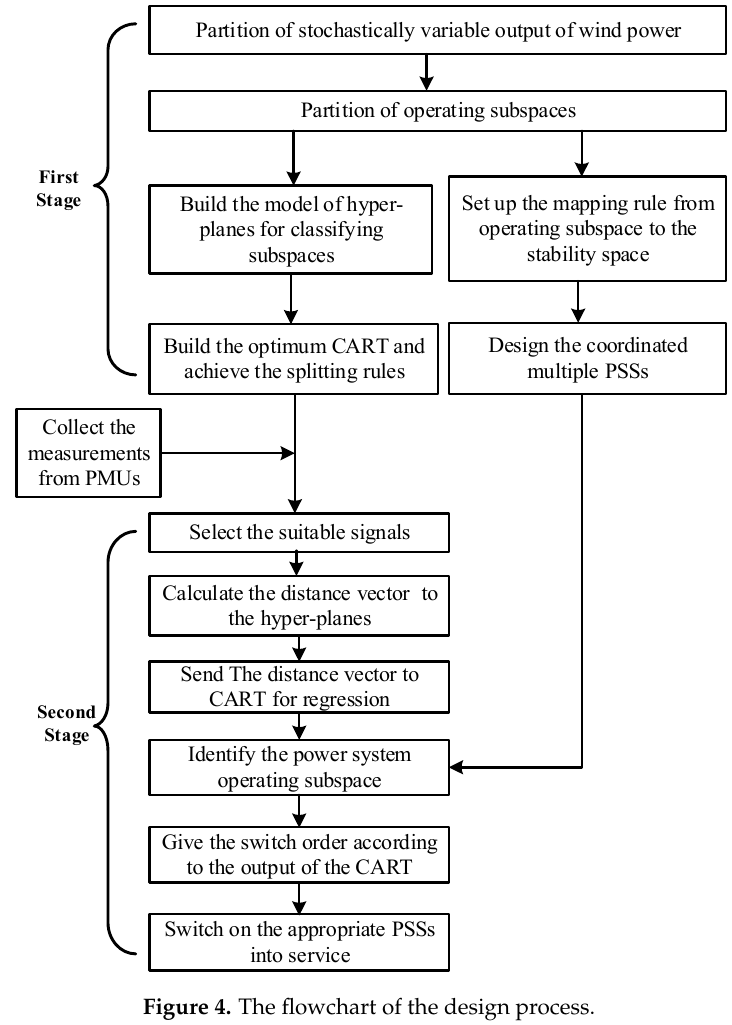
Figure 4. The flowchart of the design process. Energies 2018 , 11 , x FOR PEER REVIEW